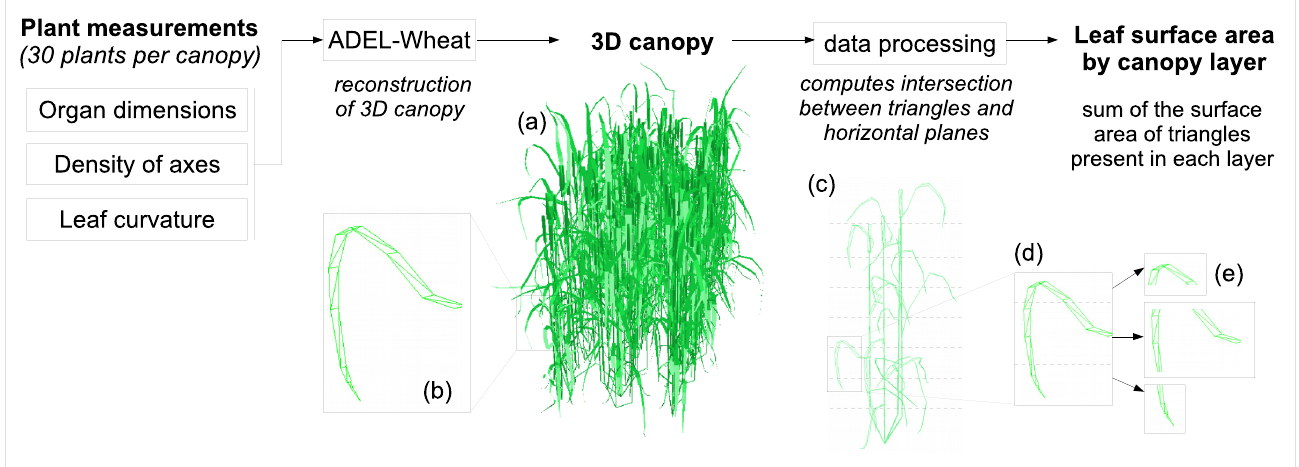
Fig 1. Assessing vertical distribution of leaf area using 3D canopies. (a) Realistic 3D canopiesat floweringstage are generatedfrom plant measurements, using ADEL-Wheat, a 3D architectural model of wheat development [27] (b) Detail of an individualleaf: each organ of the canopy is constituted of triangles,the output of the model is a list of trianglecoordinates(c) Detail of an individualplant. Dashedlines represent horizontalplanes delimitingcanopy layers. (d) Detail of an individual leaf dividedinto horizontal canopy layers (e) Output of the data processingcode is list of trianglesfor each layer, from which leaf surface area is computed, for each canopy